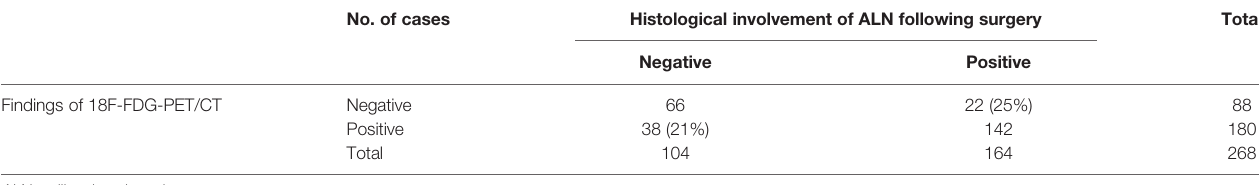
TABLE 3 | Relationship between the 18 F-FDG-PET/CT fi ndings and the histological involvement of axillary lymph nodes following surgery.